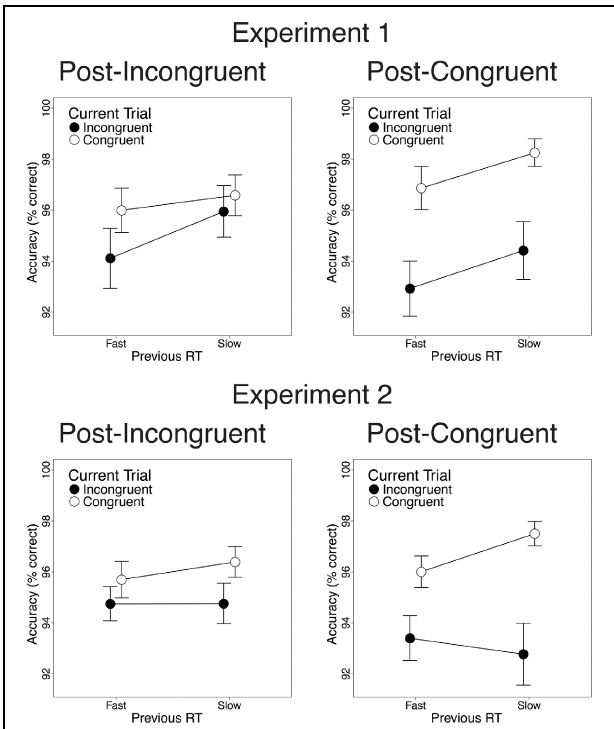
FIGURE 5 | The effects of previous-trial RT tertile on current-trial congruency effects in the accuracy data. Congruency effects did not differ after the 33% slowest vs. the 33% fastest incongruent trials [Experiment 1: t ( 22 ) = 0 . 91, n.s .; Experiment 2: t ( 25 ) = 0 . 70, n.s .]